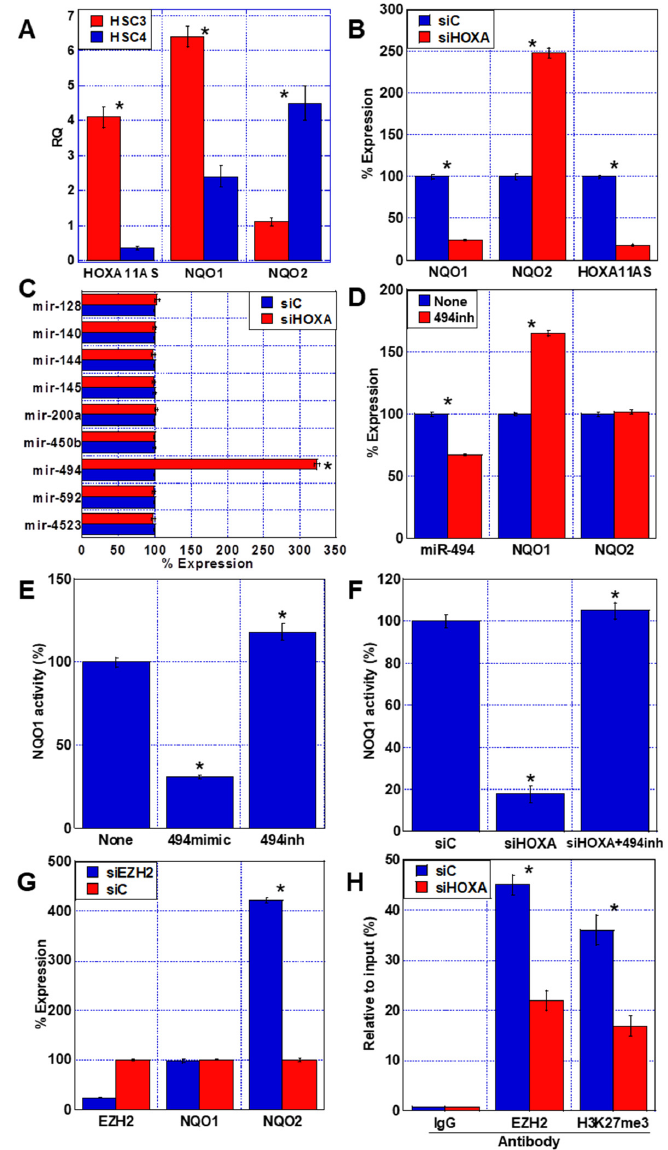
Figure 2. Roles of HOXA11-AS in expression of NQO1 and NQO2 . ( A ) Expression of HOXA11-AS , NQO1 , and NQO2 RNAs in HSC3 and HSC4 human OSCC carcinoma cell lines. ( B ) Effect of knockdown of HOXA11-AS on expression of HOXA11-AS , NQO1 , and NQO2 RNAs in HSC3 cells. ( C ) Effect of knockdown of HOXA11-AS on expression of various microRNAs associated with NOQ1 expression in HSC3 cells. The references are shown in Table 1. ( D ) Effect of inhibiting miR-494 on the expression of miR-494 , NQO1 , and NQO2 in HSC3 cells. ( E ) Effect of miR-494 mimic and miR-494 inhibitor in HSC3 cells. ( F ) Effect of HOXA11-AS knockdown and miR-494 inhibition on NQO1 activity. ( G ) Effect of EZH2 knockdown on expression of EZH2 , NQO1 , and NQO2 in HSC3 cells. ( H ) Chromatin immunoprecipitation of NQO2 in HOXA11-AS knockdown HSC3 cells. Error bars indicate the SD calculated using Student’s t -test from three independent trials. Asterisk, p < 0.05. OSCC, oral squamous cell carcinoma; NQO1 , NAD(P)H: quinone oxidoreductase 1; NQO2 , NRH: quinone oxidoreductase 2; RQ, relative quantity; siHOXA, small interfering RNA for HOXA11-AS ; siC, control small interference RNA; 494 mimic, miR-494 mimic; 494 inh, miR-494 inhibitor; EZH2 , enhancer of zeste homolog 2; siEZH2, short interference RNA for EZH2 ; H3K27me3, trimethylation of histone H3 at lysine 4.